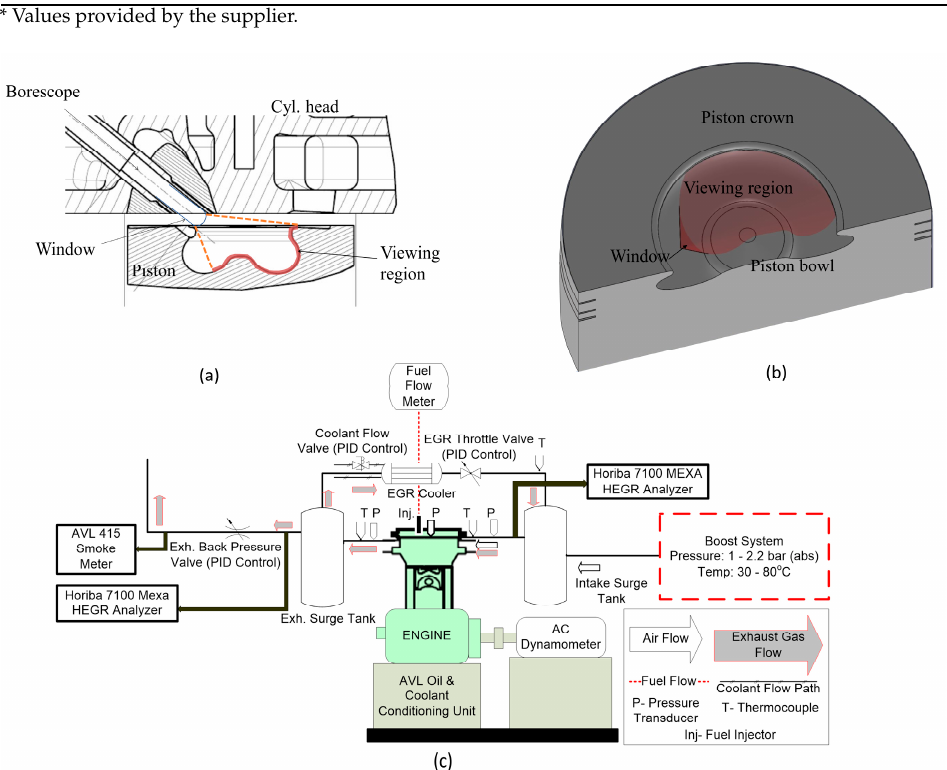
Figure 1. ( a ) Cross section showing borescope installation and viewing area (Adapted from [23]); ( b ) field of view of borescope at 10 °CA ATDC, shaded area shows surface of piston that can be seen through borescope; ( c ) system layout and process flow diagram for single cylinder engine facility.